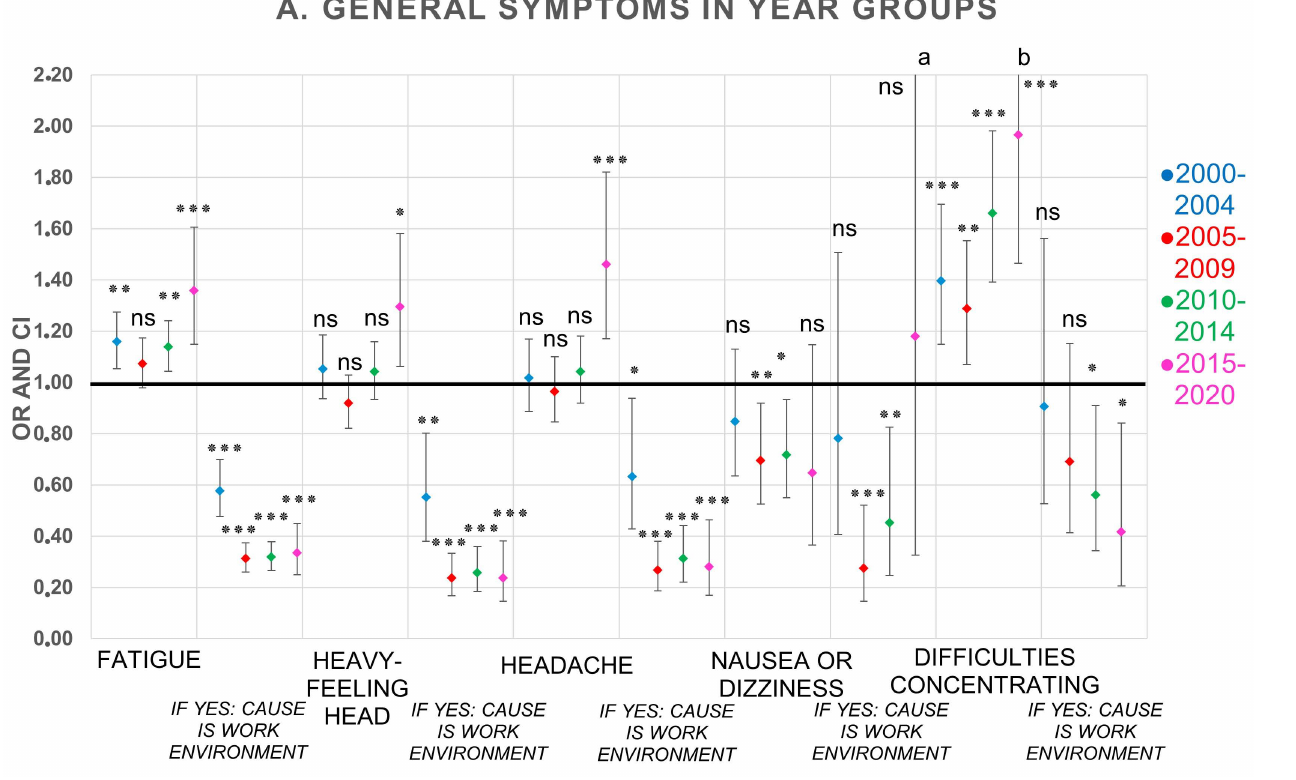
Figure 1. OR and 95% CI of 5-year groups compared to reference group (1995–1999, OR 1) for general symptoms and perceived causality to the office environment. Logistic regression analyses adjusted for sex and atopy. Number of respondents in each year group: 1995–1999 ( n = 4028); 2000–2004 ( n = 5348); 2005–2009 ( n = 7293); 2010–2014 ( n = 8904); 2015–2020 ( n = 790). a 95% CI upper limit 4.27. b 95% CI upper limit 2.64. OR = odds ratio, CI = confidence interval. p -values: * <0.05; ** ≤ 0.01; *** ≤ 0.001; ns = not